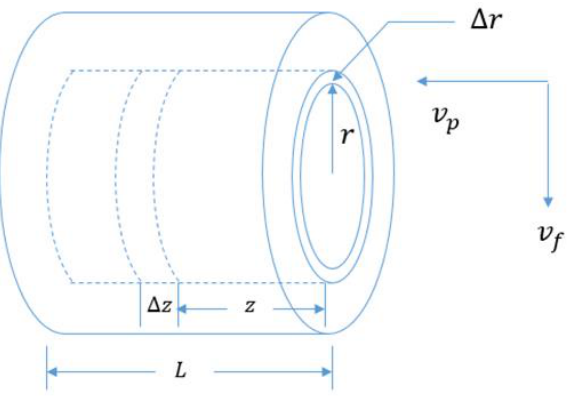
Figure 3. Differential material balance in a hollow fiber MD module with cross flow.